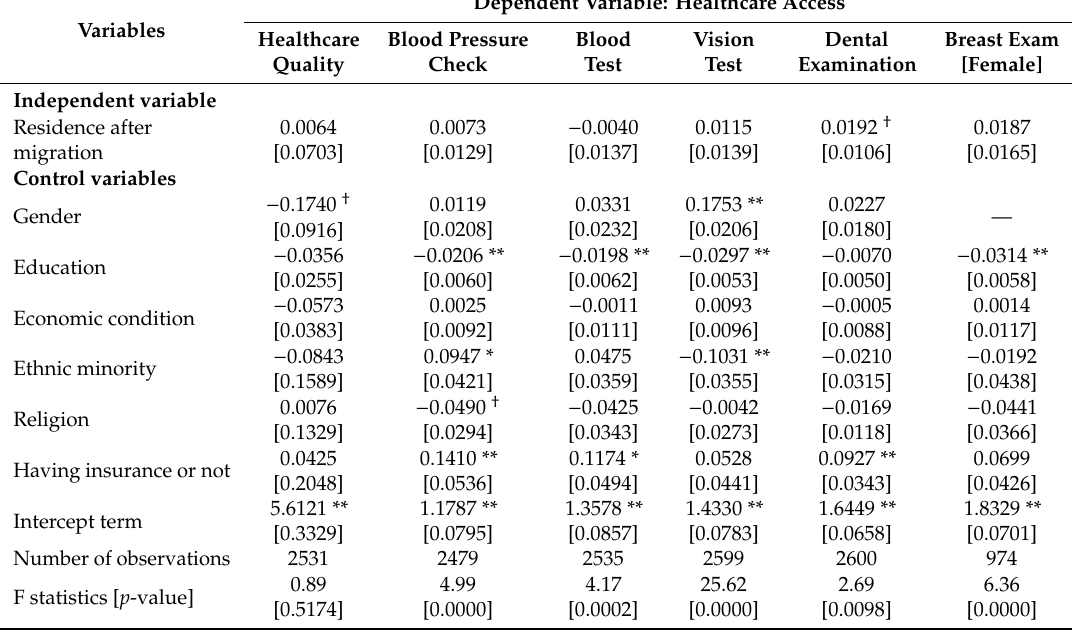
Table 6. E ff ect of migration on healthcare access for rural residents that never changed household registration